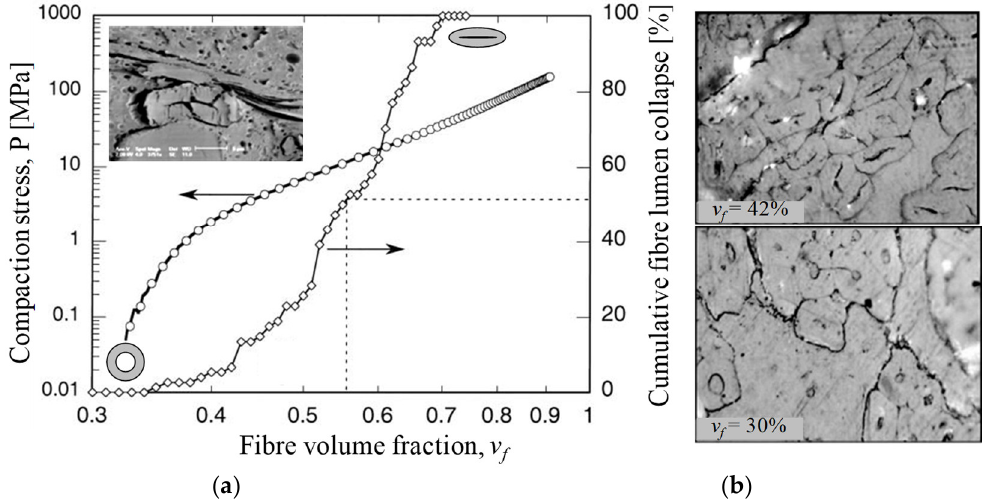
Figure 3. ( a ): Increased compaction pressure on a wood pulp random mat increases the fibre volume fraction, with partial contribution from cumulative lumen collapse-associated fibre deformation [40]; image reproduced with permission from © 2004 Wiley. Inset SEM depicts a collapsed fibre. ( b ): Lumen collapse observed in a woven jute fabric due to increase in compaction pressure at higher fibre volume fractions [13]. Reproduced with permission from © 2011 Sage.